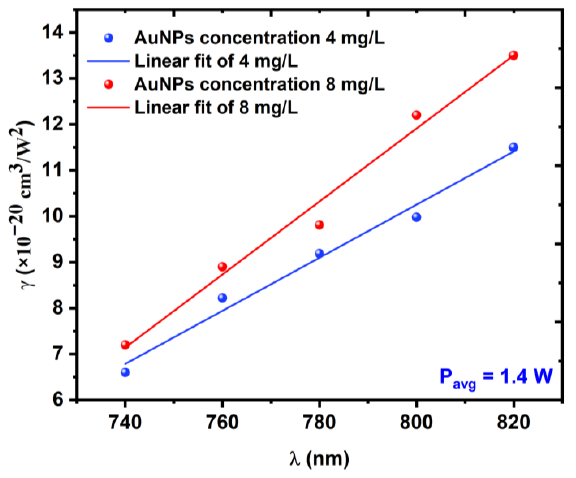
Figure 8. Variations in the NL absorption coefficient 𝛾 as a function of the excitation wavelength 𝜆 at a constant average power of 1.4 W.